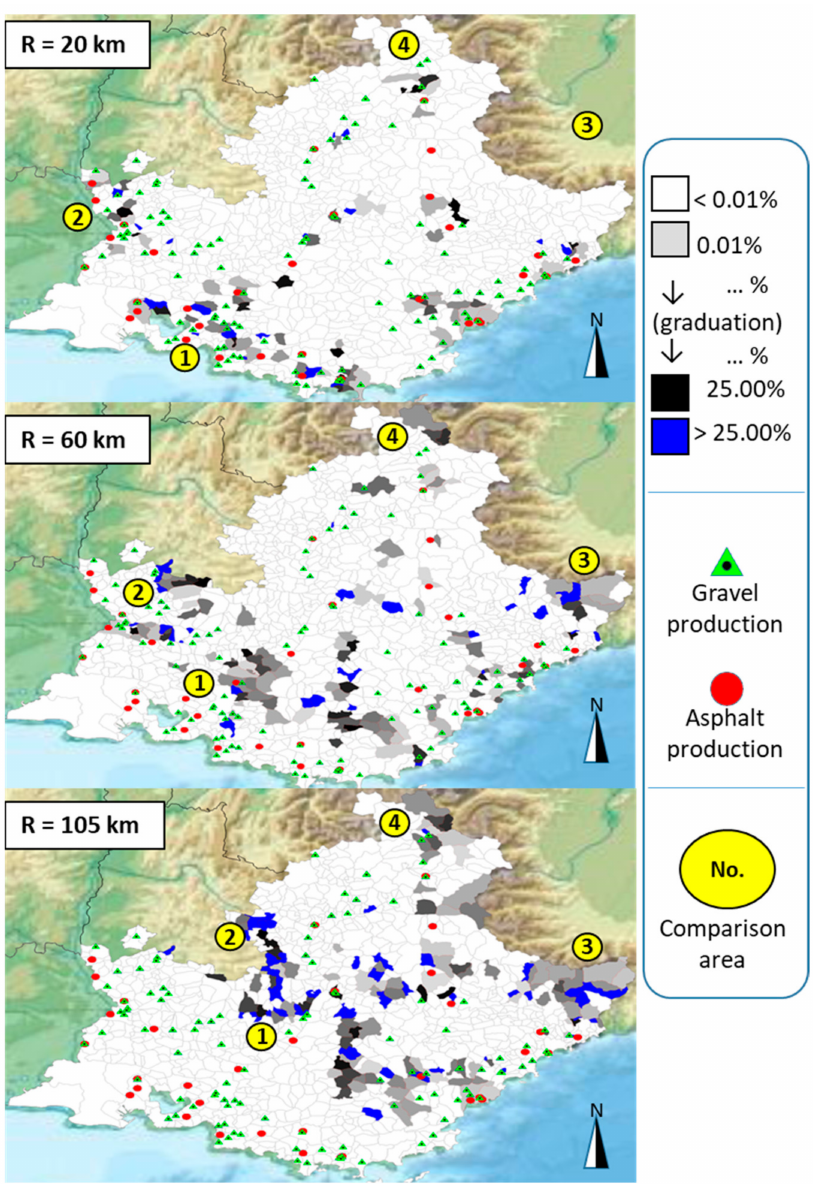
Figure 6. Distribution hypotheses for the renovation rate of each municipality as a function of the simultaneous search radius for gravel and asphalt suppliers. Source: this